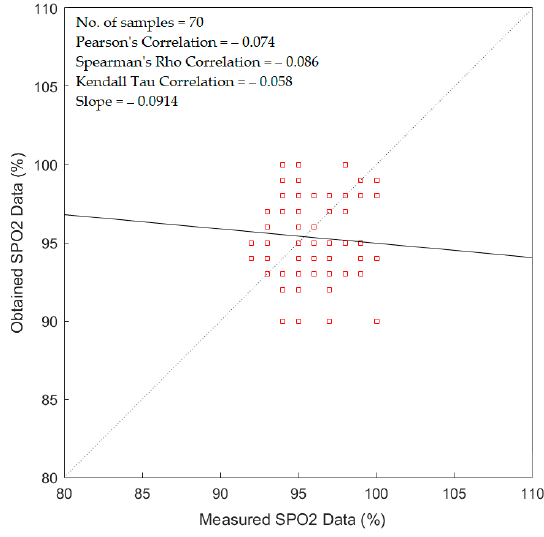
Figure 11. Correlation plot between the obtained SpO2 and the measured SpO2.